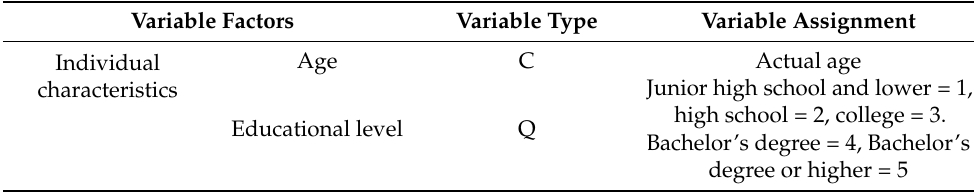
Table 3. Variable assignment.